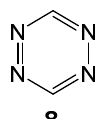
Figure 2. Plot of the GEDT, in e, vs. the electrophilicity index ω , in eV, R 2 = 1.00, for the Diels–Alder reactions of Cp 1 with ethylene 5 , acrolein 7 , and the Lewis acid (LA) complexes 7-BH 3 and 7-AlCl 3 . Recently, the P-DA reactions of nucleophilic dienes with electrophilically activated ethylenes, electron density flux (FEDF) [20]. However, there are heterodienes such as tetrazine 8 (see Chart 1) and nitroethylene 9 that participate as strong electrophiles in P-DA reactions. These type of DA reactions, which demands the nucleophilic activation of the ethylene to the reaction takes place, have been classified as the reverse electron density flux (REDF)